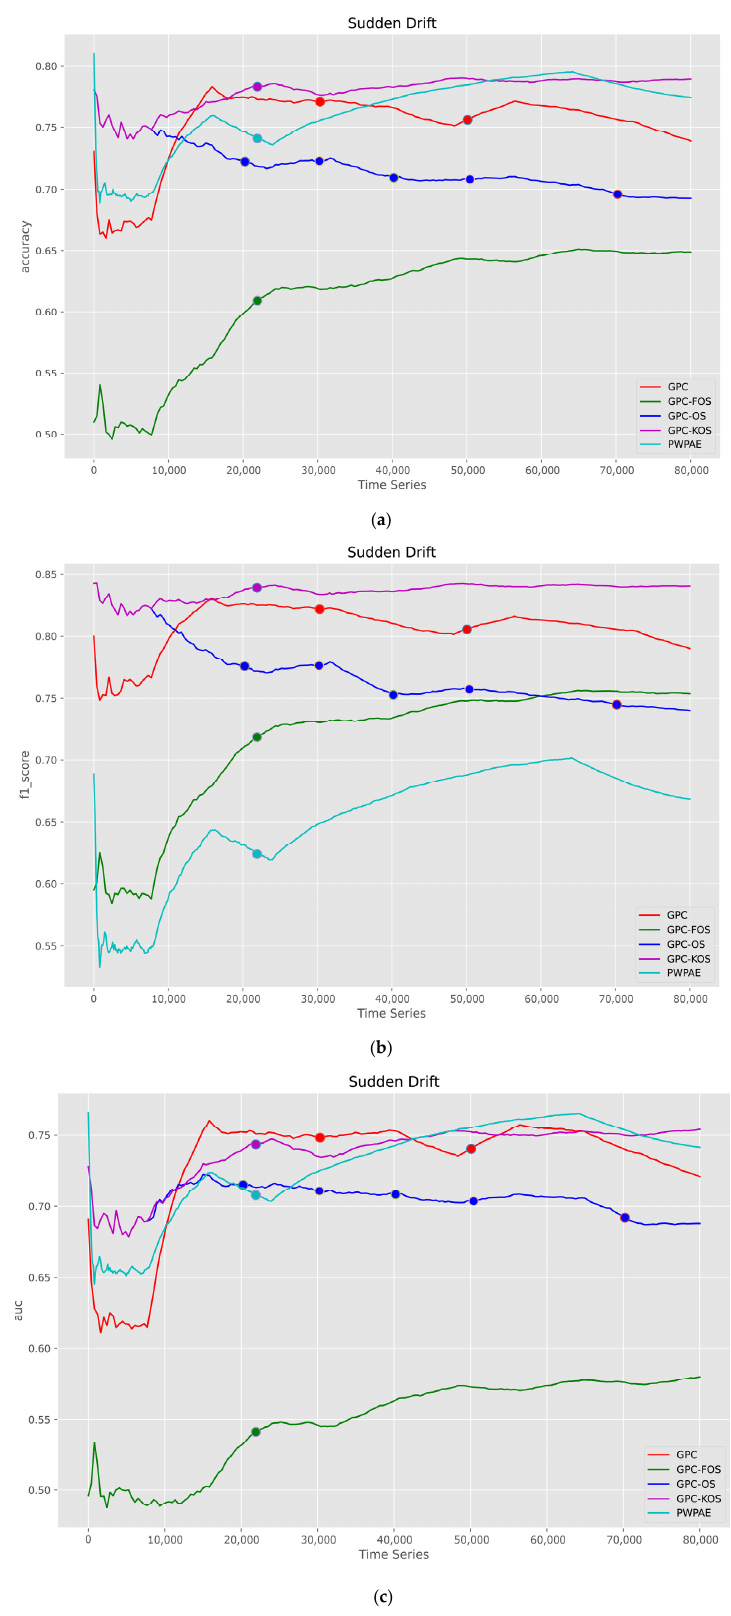
Figure 9. Visualisation of classification metrics as time series for a sudden type of drift—( a ) accuracy, ( b ) F1-score, ( c ) AUC.